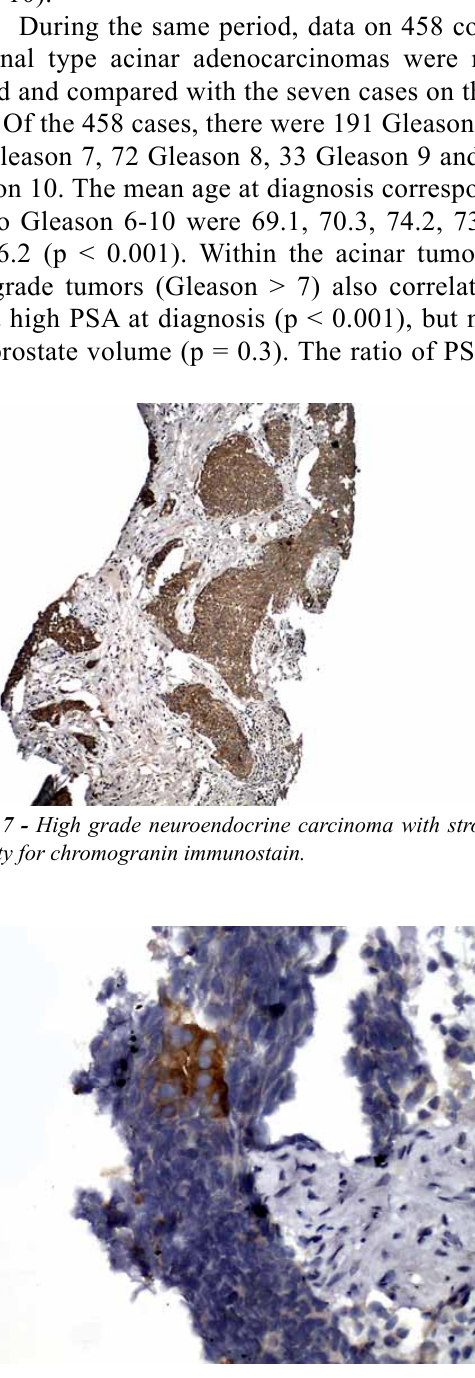
Figure 9 - Occasional neuroendocrine carcinoma tumor cells were positive for PSA immunostain.